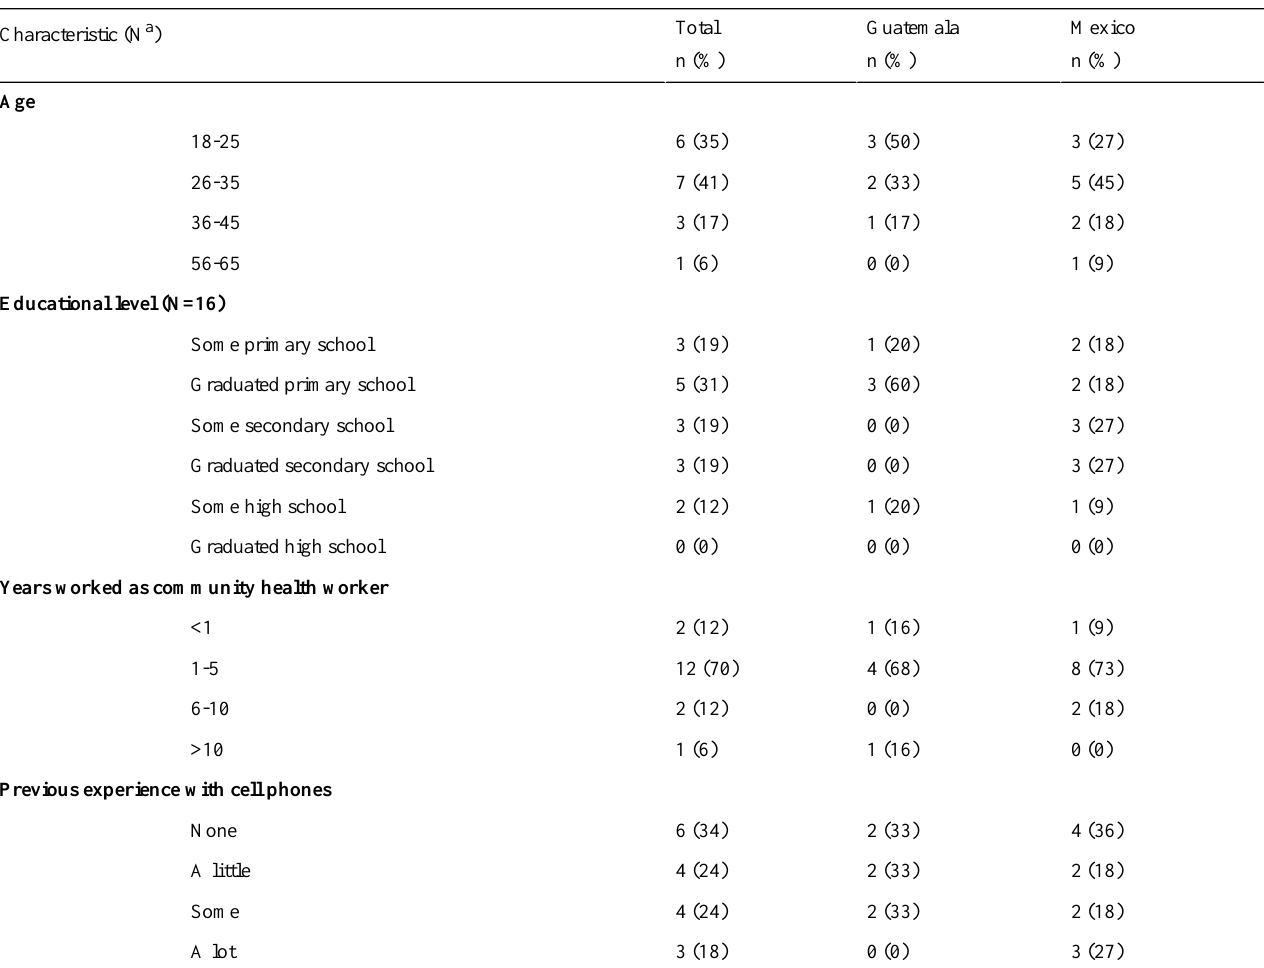
Table 1. Characteristics of study population.